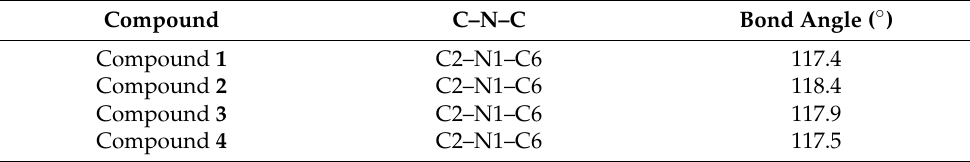
Table 3. C–N–C bond angles around the pyridine N-atoms in compounds 1 – 4 .